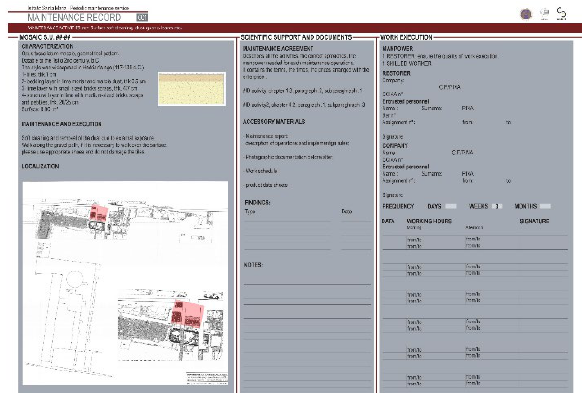
Figure 11: the maintenance report for the preventive conservation of the mosaic. It contains the description, localization, and recommendations for the conservation. In the last (right) part, the card to be filled by the employment of the conservation operation.